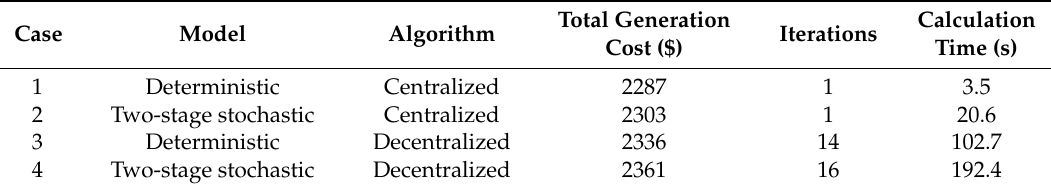
Table 2. Comparisons of four typical